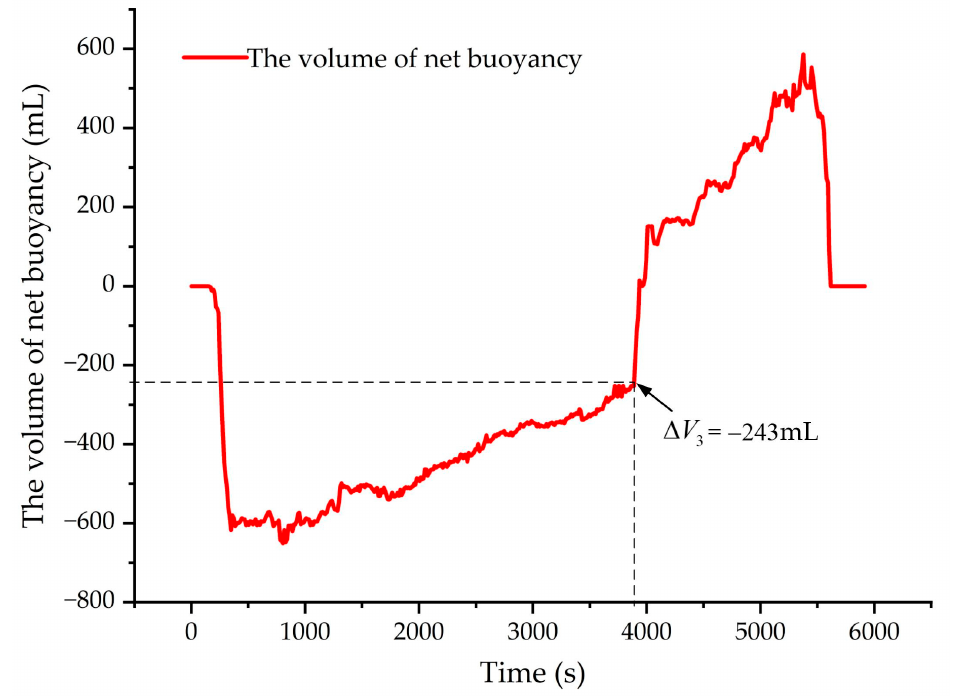
Figure 17. The volume of the net buoyancy curve of the profile.